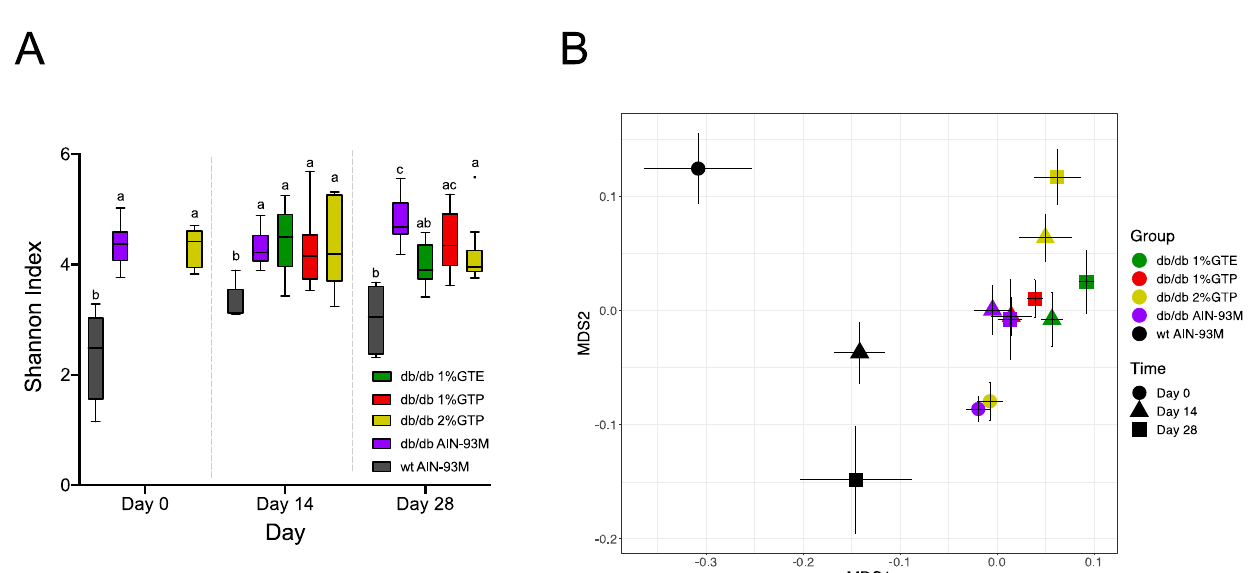
Figure 3. Effect of GTE and GTP treatments on the gut microbiota. ( A ) Decrease in Shannon index. Kruskal–Wallis test followed by Dunn’s post hoc was performed between groups at each time point. Data points not sharing common compact letters were significantly different from each other ( p < 0.05). Boxes show the medians and the interquartile ranges (IQRs), the whiskers denote the lowest and highest values that were within 1.5 times the IQR from the first and third quartiles, and outliers are shown as individual points. ( B ) Alteration in gut microbiota structure. Multidimensional scaling plots for gut microbiota structure based on weighted UniFrac distance. Each data point represents the mean ordination value and the error bar represents the SEM of each group. Stress = 0.12.